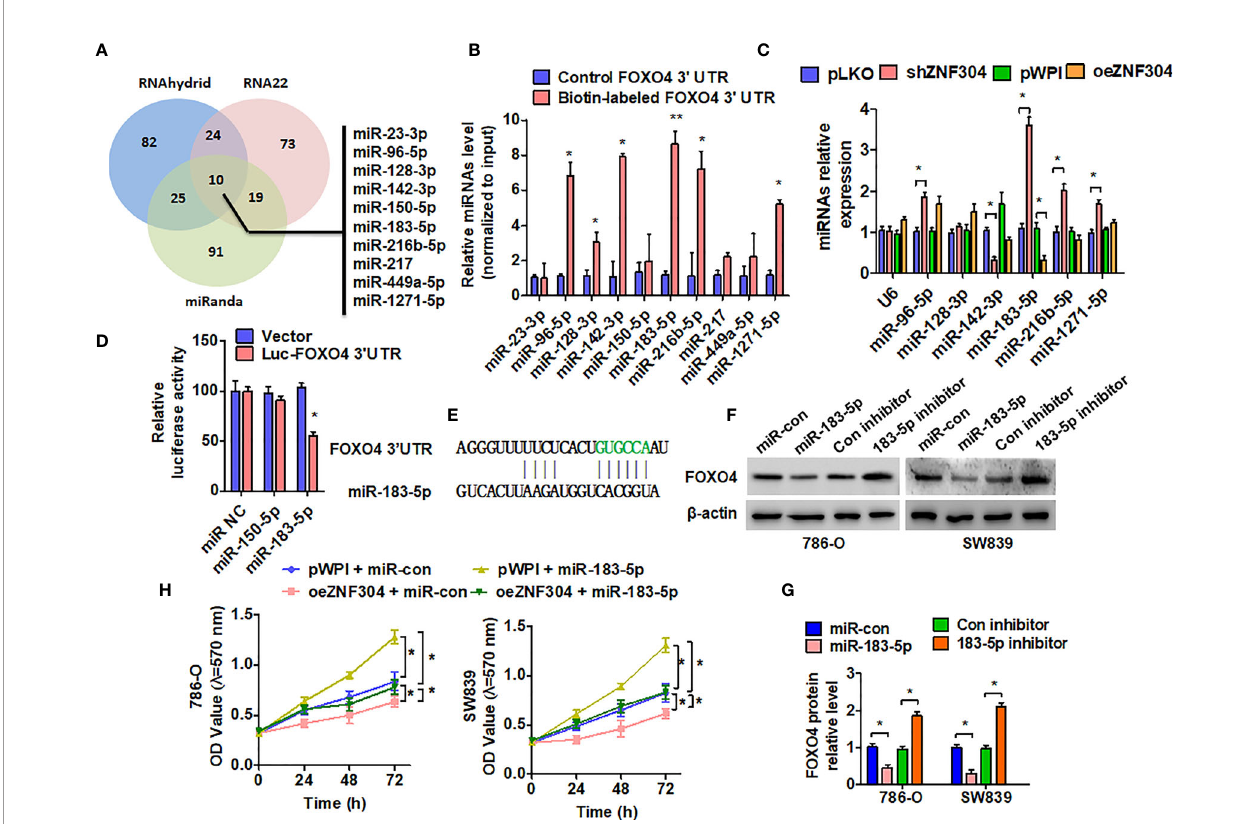
FIGURE 4 | miR-183-5p mediates ZNF304-regulated FOXO4 expression in ccRCC. (A) Potential microRNAs targeted 3 ′ UTR of FOXO4 were predicted in three online target-prediction programs, and showed with venn diagram. (B) Biotin pull-down assay was used to enrich miRNAs, and RT-qPCR was used to detect these candidate miRNAs. (C) 786-0 cells were transfected with oeZNF304 or shZNF304 or control vectors. Candidate miRNAs were detected by using RT-qPCR. U6 served as a negative control. (D) 786-0 cells were co-transfected with the FOXO4 3 ′ UTR and miR-183-5p or miR-150-5p mimics. Luciferase reporter assays showed that miR-183-5p reduced FOXO4 3 ′ UTR luciferase activity. (E) The prediction of miR-183-5p binding site in the FOXO4 3 ′ UTR. (F, G) 786-0 and SW839 cells were transfected with the indicated miRNAs, and then FOXO4 protein expression was measured by western blotting. (H) 786-0 and SW839 cells were co- transfected with the indicated miRNAs and vectors, and cell viability was measured by MTT. All data are from three independent experiments and expressed as the mean ± SEM. *P < 0.05, **P < 0.01 vs. the corresponding